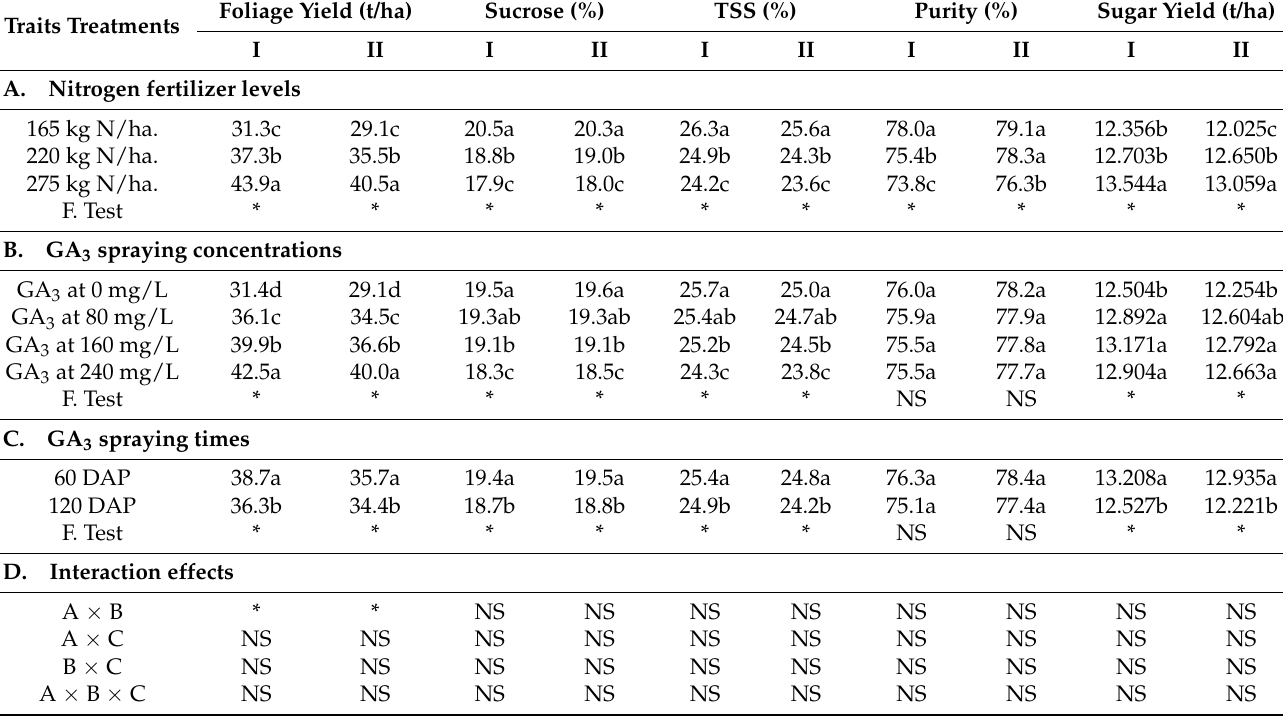
Table 3. Means of foliage yield (t/ha), sucrose (%), TSS (%), purity (%), and sugar yield (t/ha) as affected by nitrogen fertilizer levels and GA 3 spraying concentrations and its application time in the 2014/2015 (I) and 2015/2016 (II) seasons. Foliage Yield (t/ha) Sucrose (%) TSS (%) Purity (%) Sugar Yield Traits Treatments